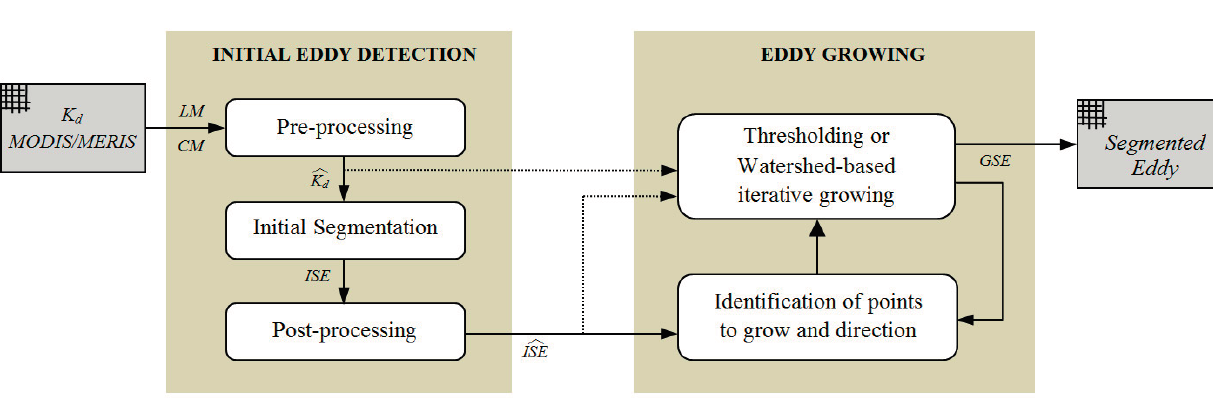
Figure 4. Methodology for the automatic segmentation of eddies using optical